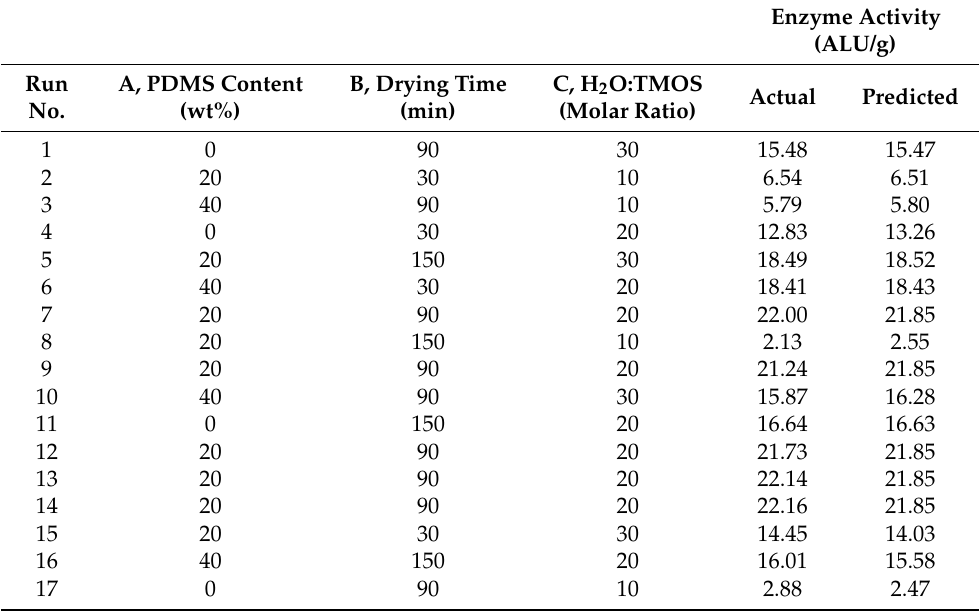
Table 1. Experimental matrix and results in the Box–Behnken design experiment. A—PDMS content